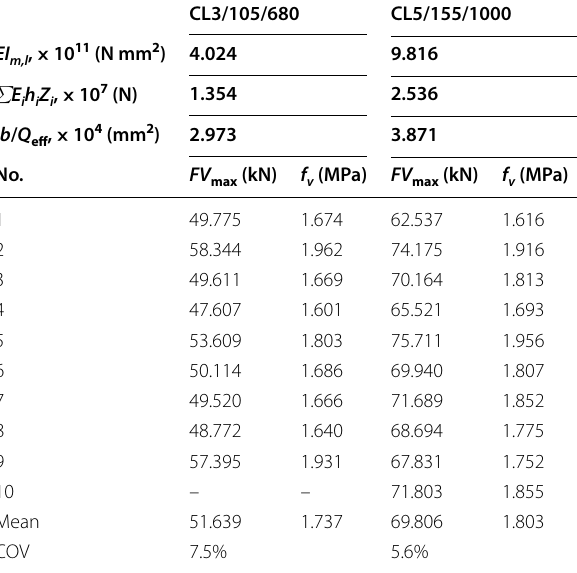
Table 8 Experimental results for CLT shear panels